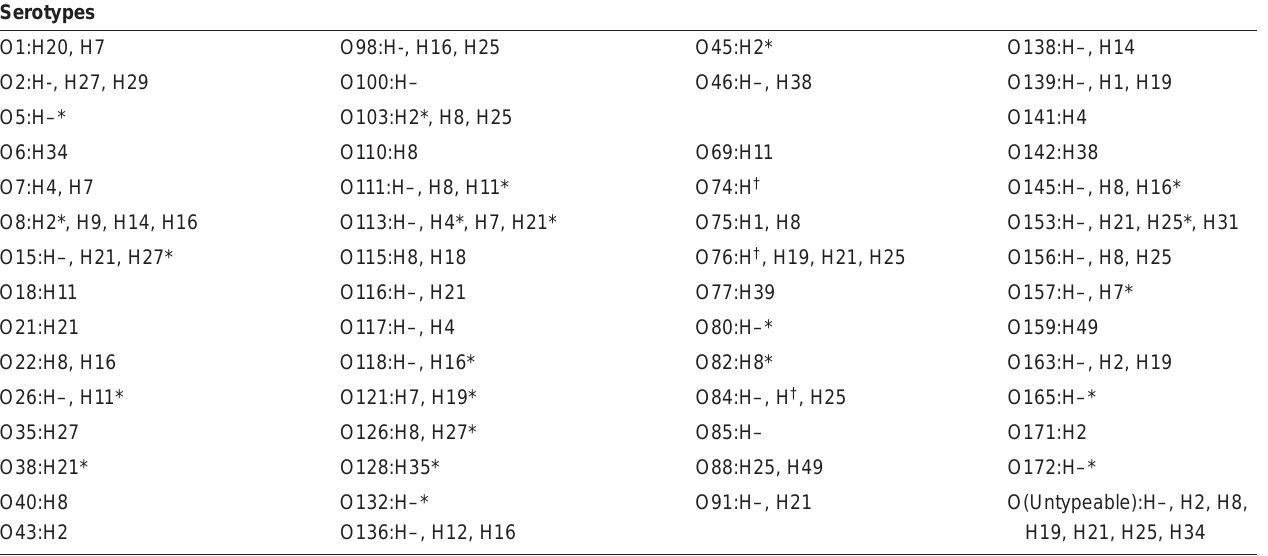
TABLE 4 Verotoxigenic Escherichia coli serotypes isolated from cattle and meat sources in Canada between 1983 and 2000